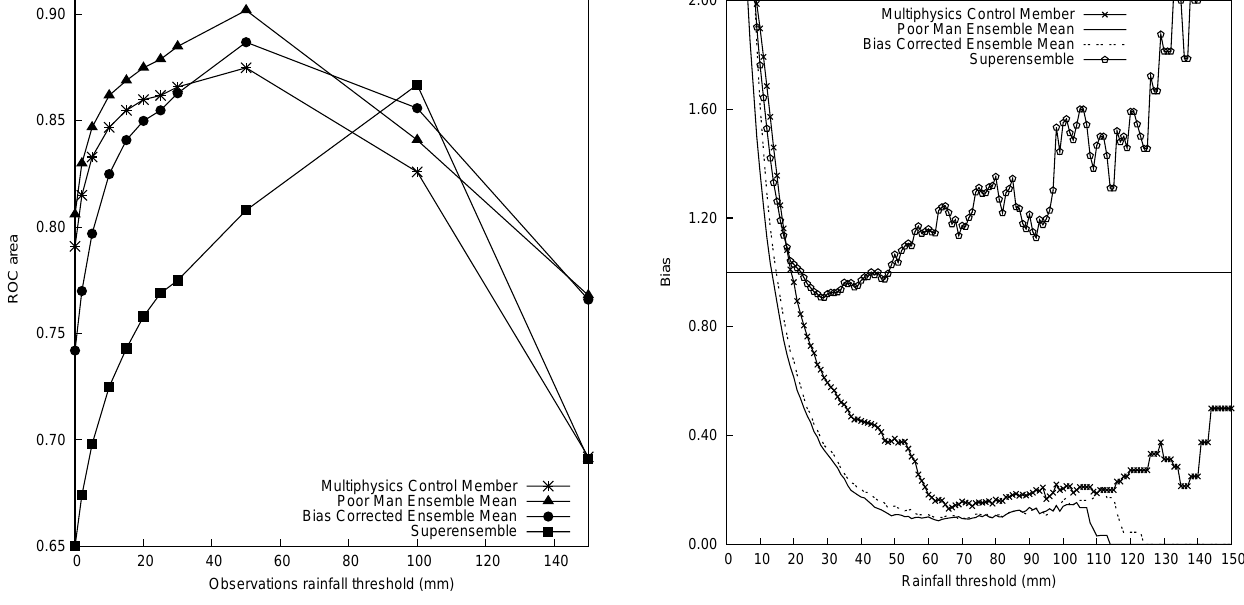
Fig. 6. ROC area for the multiphysics ensemble control member, the multiphysics ensemble mean, the bias corrected ensemble mean and the superensemble, as functions of different rainfall event thresholds. Note: training period 19 MEDEX cases and forecast period September–December 2001.